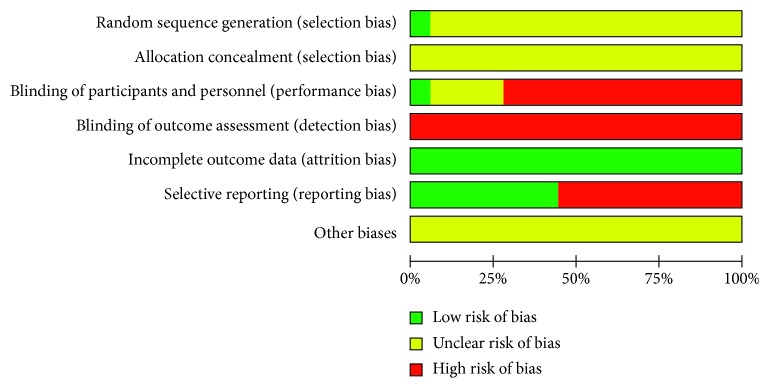
Risk-of-bias graph.